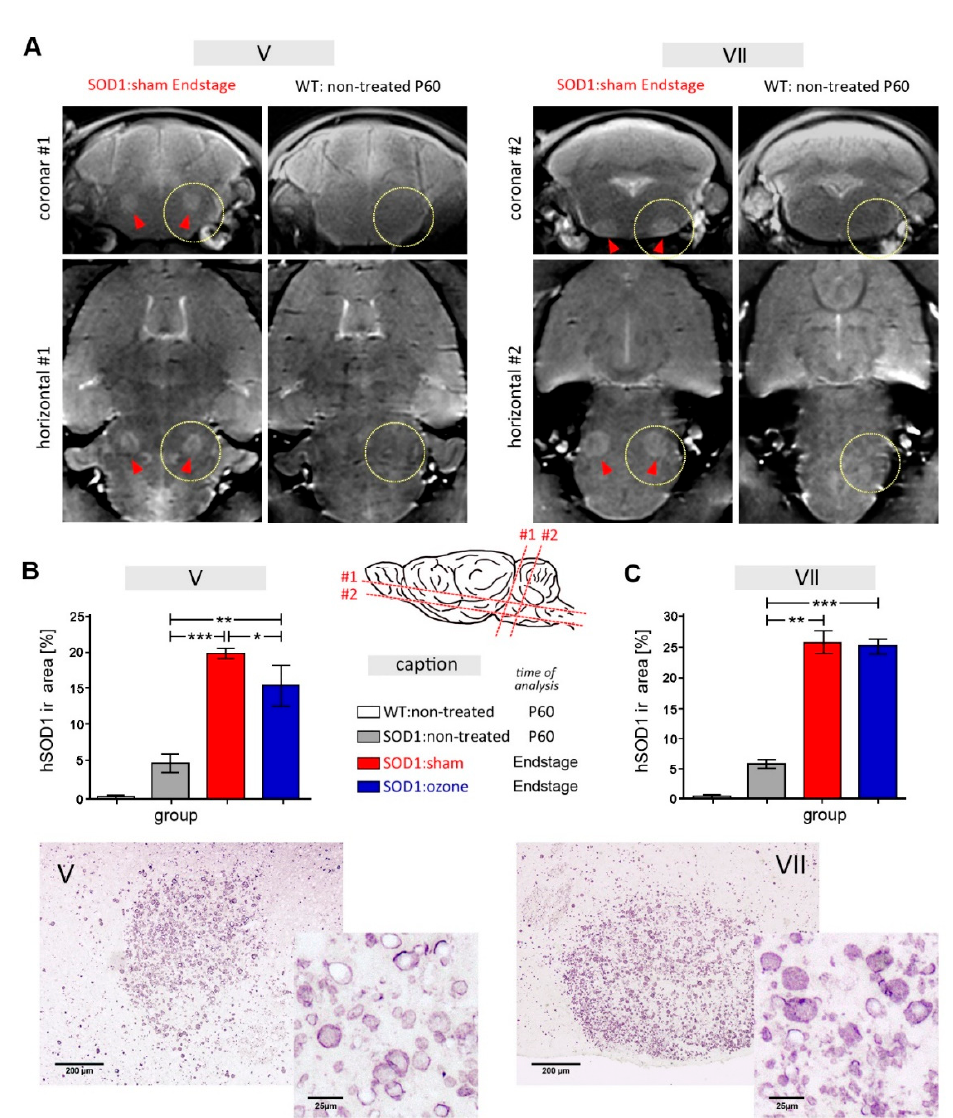
Figure 3. MRI and immunohistochemical analysis of human SOD1-related vacuolization in brainstem motor nuclei. ( A ) MRI analysis of SOD1 G93A mice revealed a marked increase in T2-weighed signals in the trigeminal (left four images, #1) and facial (right four images, #2) motor nuclei, shown in coronary and horizontal planes according to drawing. Arrowheads indicate the position of motor nuclei V and VII, respectively, in the yellow circled area from a representative MRI of a SOD1 G93A mouse at end stage. For comparison, MRIs of C57BL/6J wild-type (WT) mice are shown. ( B , C ) Quantification of human SOD1-immunoreactivity in the trigeminal ( B ) and facial ( C ) nuclei of WT and SOD1 G93A mice at an early preclinical age (P60) and at end stage. Representative immunohistochemical stains of brain nuclei in end-stage disease taken from sham-treated mice are shown below each graph. Data are presented as mean ± SEM ( n = 3 for all groups). Differences between groups were analyzed using the Wilcoxon–Mann–Whitney test, with * p ≤ 0.05, ** p ≤ 0.01, *** p ≤ 0.001.